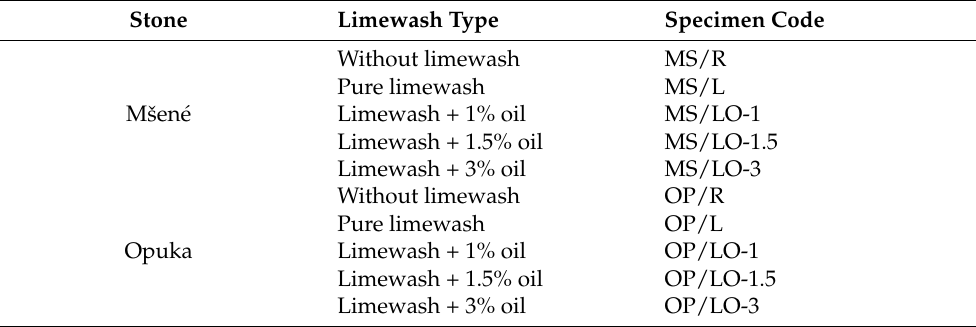
Table 2. Identification of the type of specimens